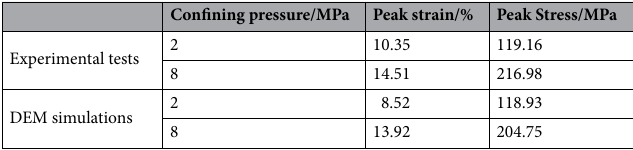
Table 3. Comparison of peak stresses and strains between the DEM simulations and the experimental tests.